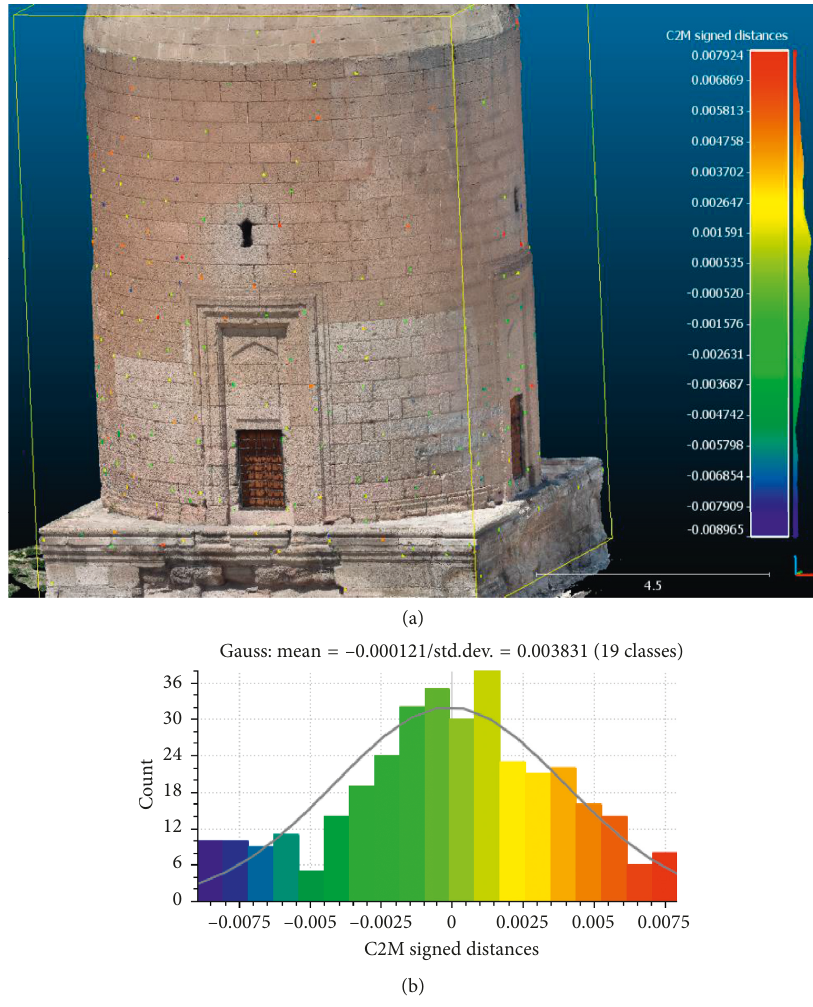
Figure 5: Color-encoded surface deviation of the historic cupola and distance deviation distribution graphs. Table 4: Results of self-calibration of the Galaxy S4 camera for target-based and targetless